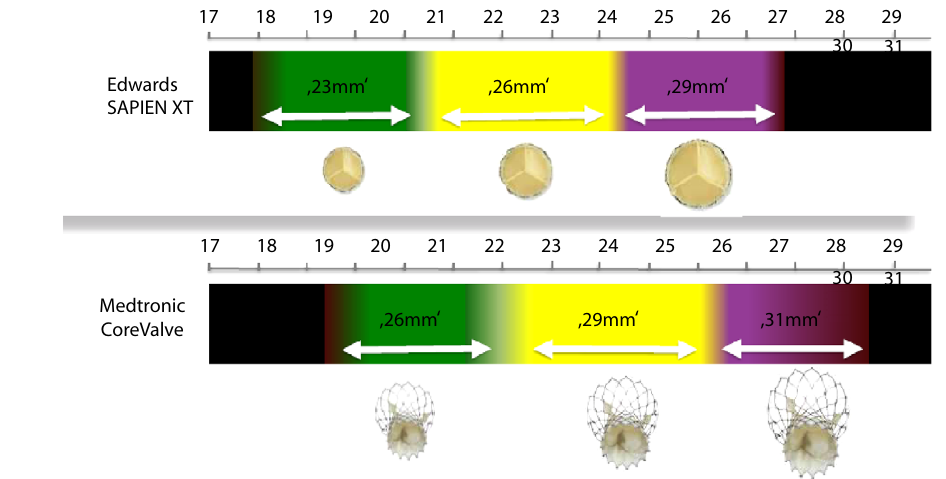
Figure 3. Commercially available TAVI devices. Above: Balloon-expandable Edwards SAPIEN/SAPIEN XT devices available in 23-mm, 26-mm and 29-mm, suitable for annulus sizes from 18–21 mm, 21–24 mm and 24–27-mm respectively. Below: Self-expanding CoreValve R (cid:13) devices available in 26-mm, 29-mm and 31-mm, suitable for annulus sizes from 20–23 mm, 23–27 mm and 26–29 mm.